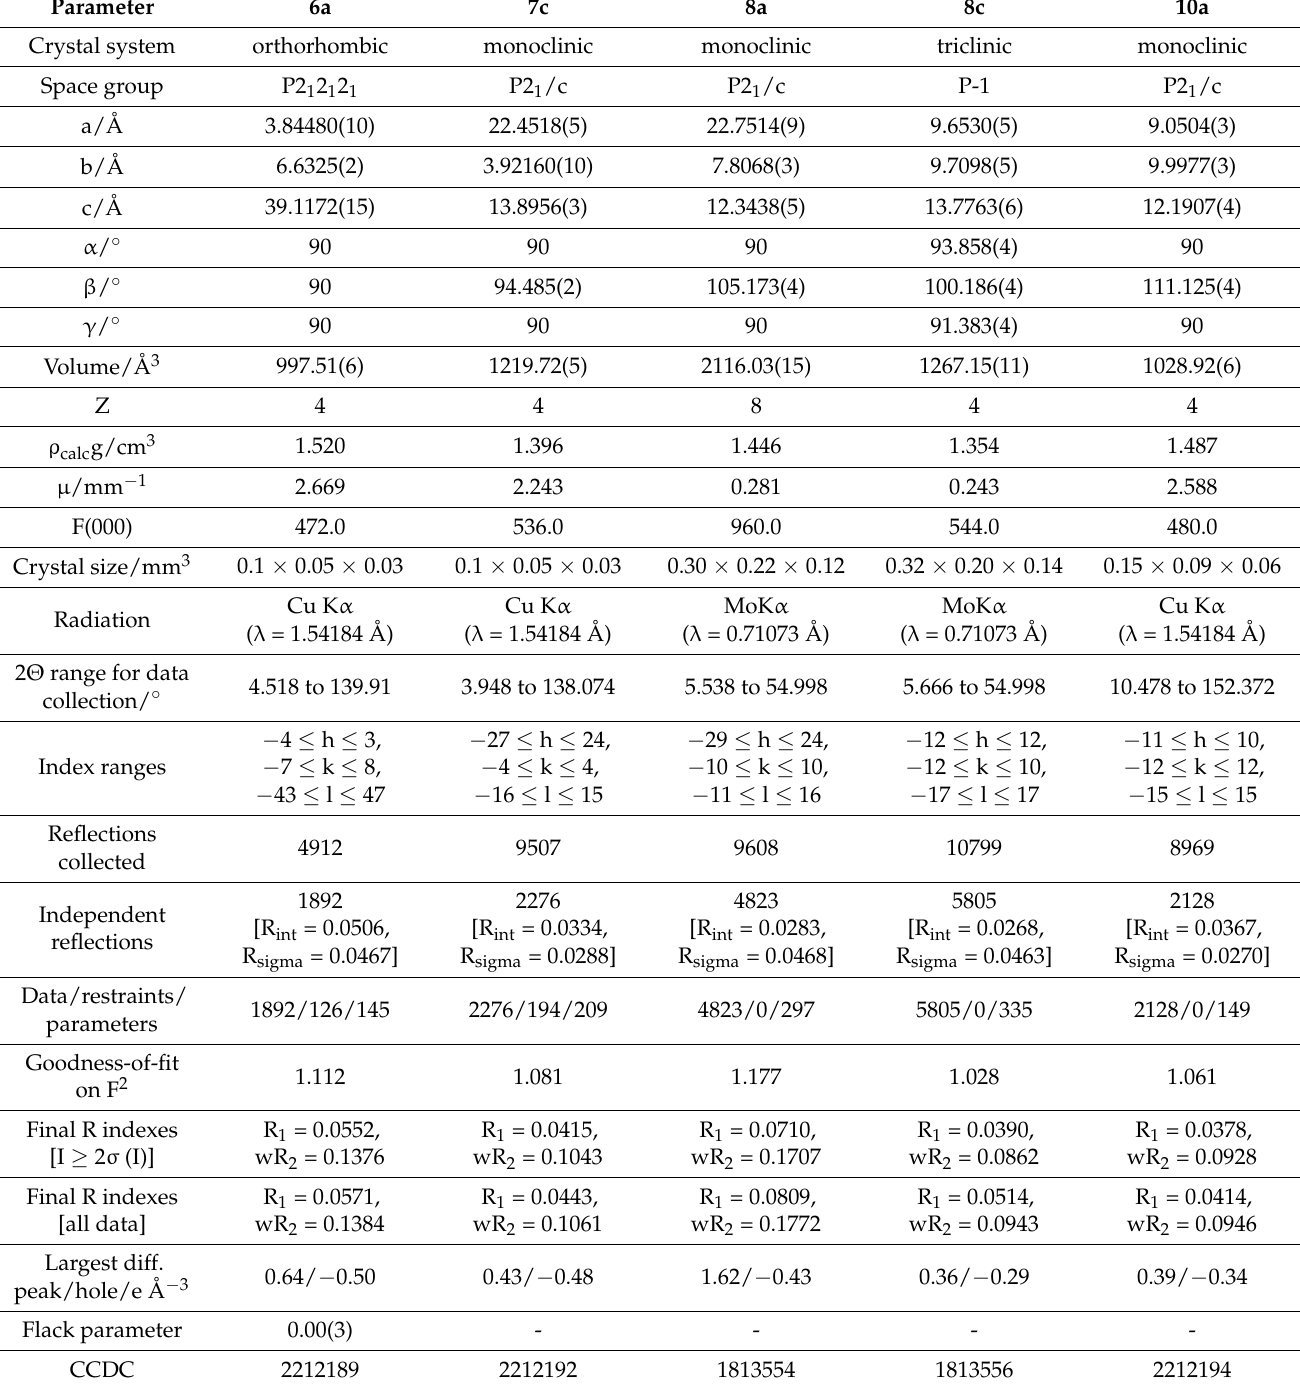
Table 1. Crystal data and structure refinement for 6a , 7c , 8a , 8c and 10a